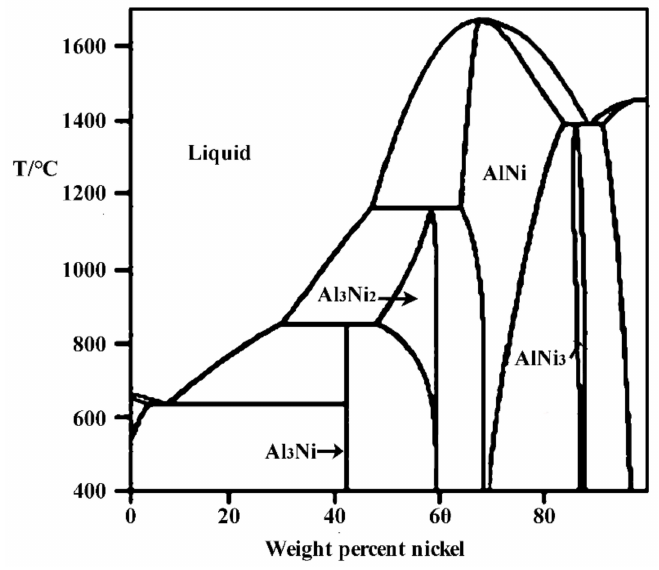
Figure 2. The phase diagram of Al-Ni